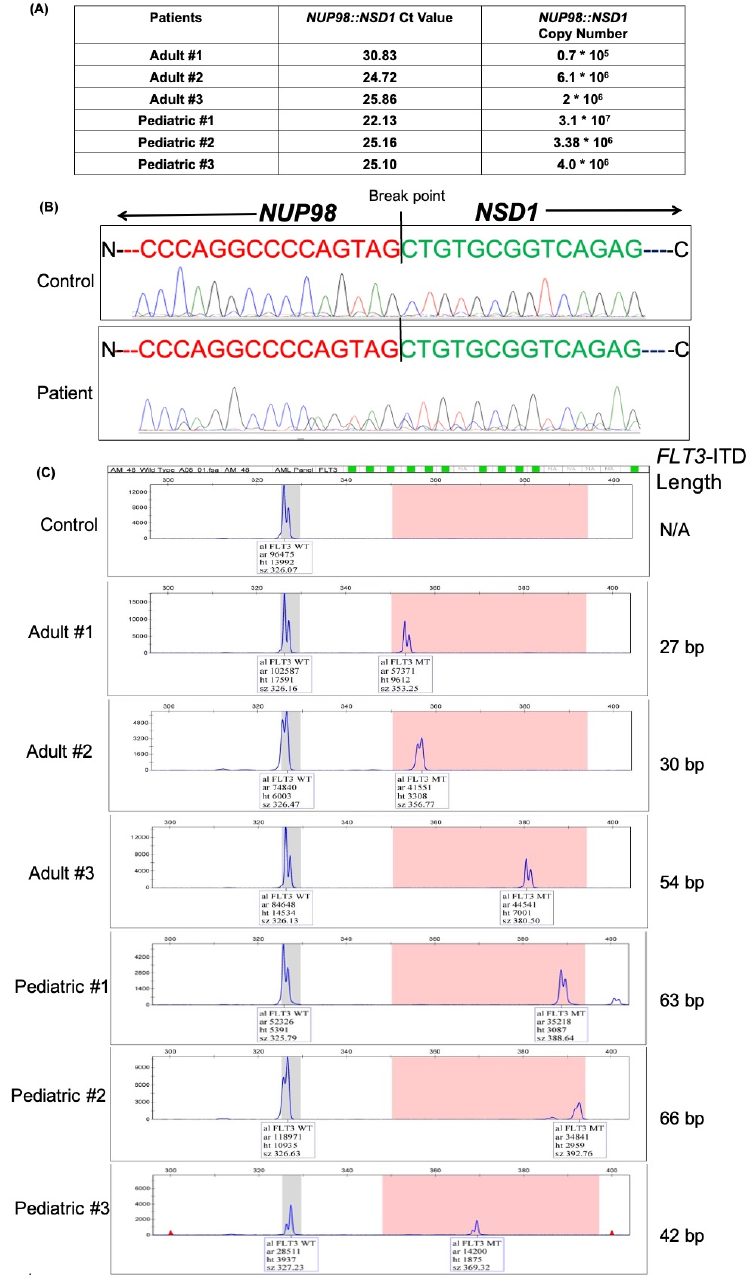
Figure 2. ScreeningandvalidationofAMLpatients( A )qRTPCRdatarevealedthepresenceof